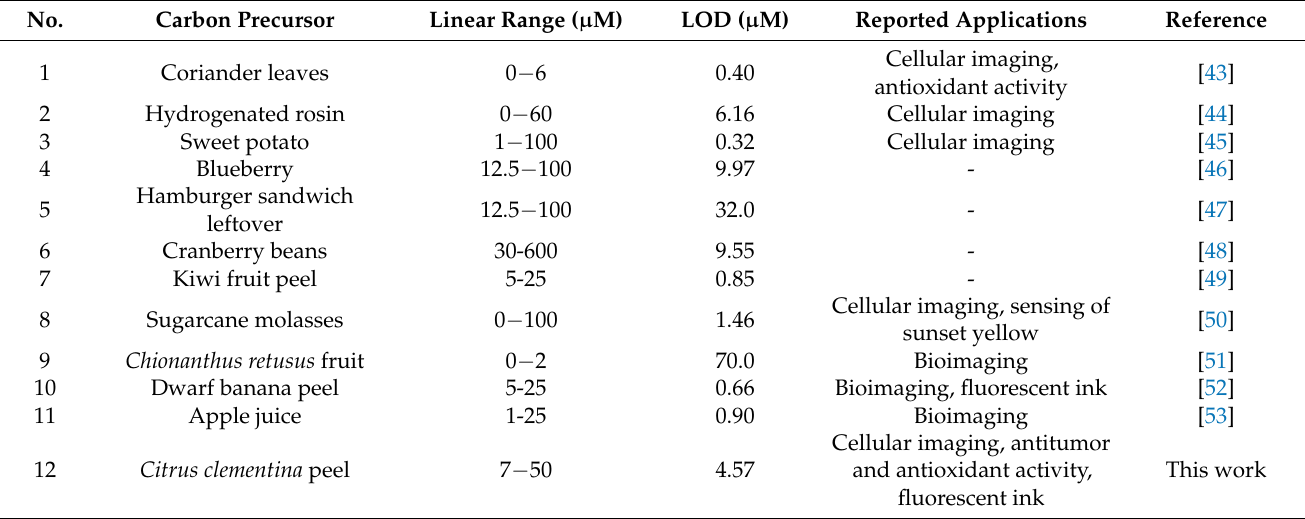
Table 2. Comparison of the biomass-derived CQDs used for the detection of Fe 3+ ions with some reported works.